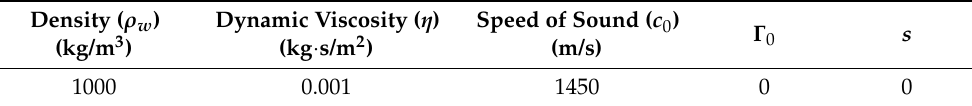
Table 3. EOS parameters for water